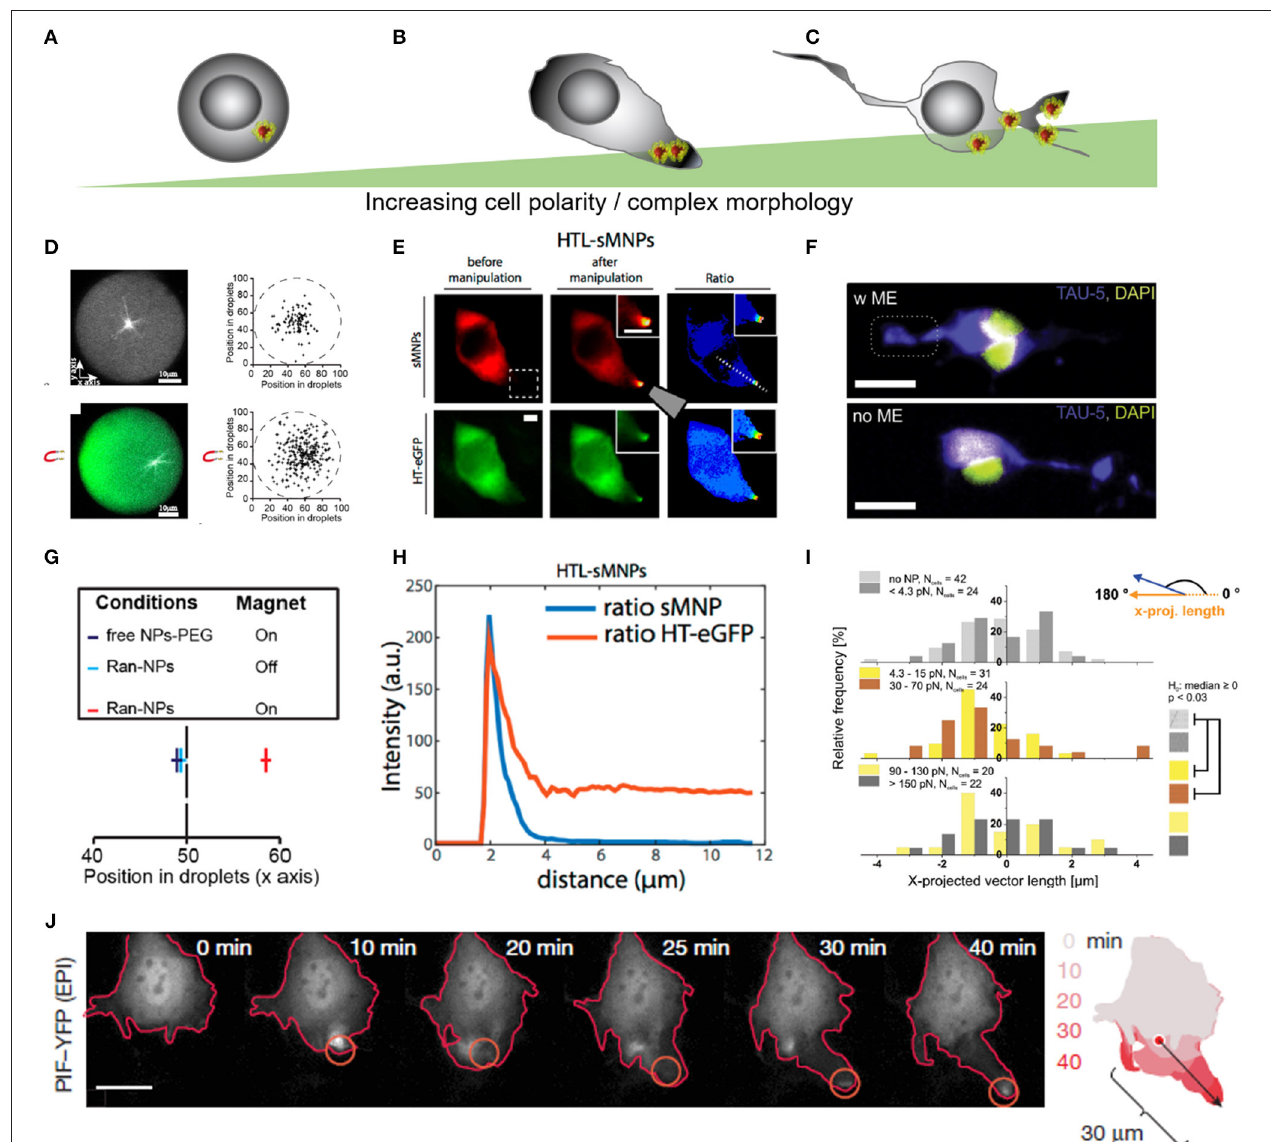
FIGURE 5 | Force-mediated protein sorting inside cells across different levels of complexity in cell morphology. (A–C) Schematic representation of different levels of cell complexity ranging from almost perfectly round to highly branched structures. (D) Microtubules nucleation in artificial, micro-scaled lipid droplets de-centralize the nucleation zone through the application of magnetic field gradient. Magnetic forces off-center nucleation position of microtubules through repulsion. Forces were estimated in the femtonewton range. (E) Altered protein positioning (HaloTag-eGFP) through nanomagnetic forces operated by magnetic tweezers in HeLa cells. Scale bar = 10 µ m. HTL-sMNPs, HaloTag-ligand-silica-based magnetic nanoparticles. (F) Primary cortical neurons with superparamagnetic nanoparticles re-assemble Tau proteins toward the magnetic field gradient when exposed to a permanent magnetic field. Scale bar = 16 µ m. (G) Microtubules nucleation position of RanGTP-magnetic nanoparticles (Ran-NPs) without (Off) and with (On) magnetic forces. (D,G) Reproduced with permission from Bonnemay et al. (2013), Copyright © 2013, American Chemical Society. (H) Surface intensity plot shows correlation between nanoparticles (HTL-sMNPs = sMNPs) and protein assembly (HT-eGFP) in transfected HeLa cells dropping away from the magnetic tip. (E,H) Reproduced with permission from Etoc et al. (2015), Copyright © 2015, American Chemical Society. (I) Histogram plot for the nanomagnetic force range were protein assembly was significant different from its native distribution. (F,I) Adapted from Kunze et al. (2015), Copyright © 2015, American Chemical Society. (J) Force-mediated local activation actin cytoskeleton dynamics through dragging Rho-family GTPases proteins. Reproduced with permission from Levskaya et al. (2009), Copyright © 2009, Springer Nature.